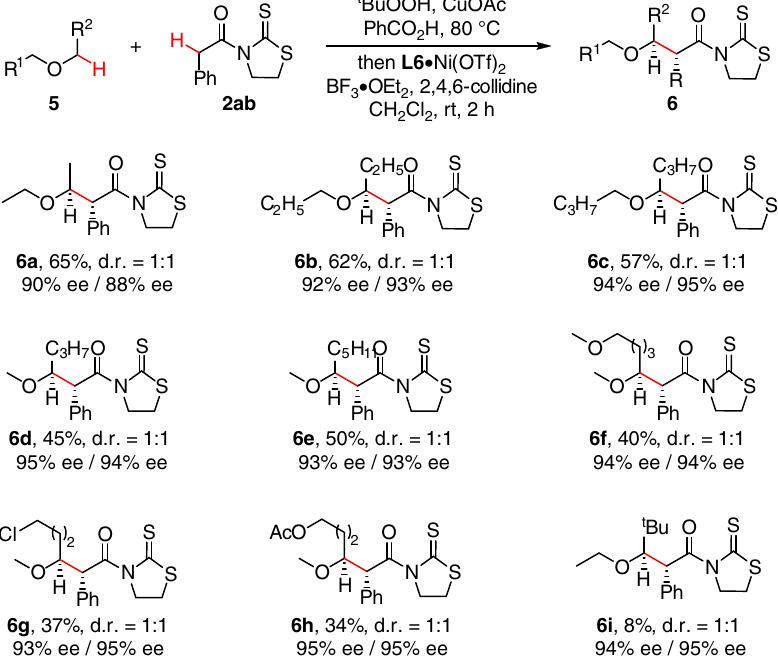
Fig. 4 The scope of acyclic saturated ethers. Conditions: PhCOOH (0.5 mmol, 2.5 equiv), CuOAc (2.5 mol%), t BuOOH in decane (3.0 equiv) in ether (1.0 mL) at 80 °C for 6 – 12 h, followed by 2 (1.0 equiv), L6·Ni(OTf) 2 (10 mol%), 2,4,6-collidine (3.0 equiv), and BF 3 ·OEt 2 (4.0 equiv) in CH 2 Cl 2 (0.4 mL)